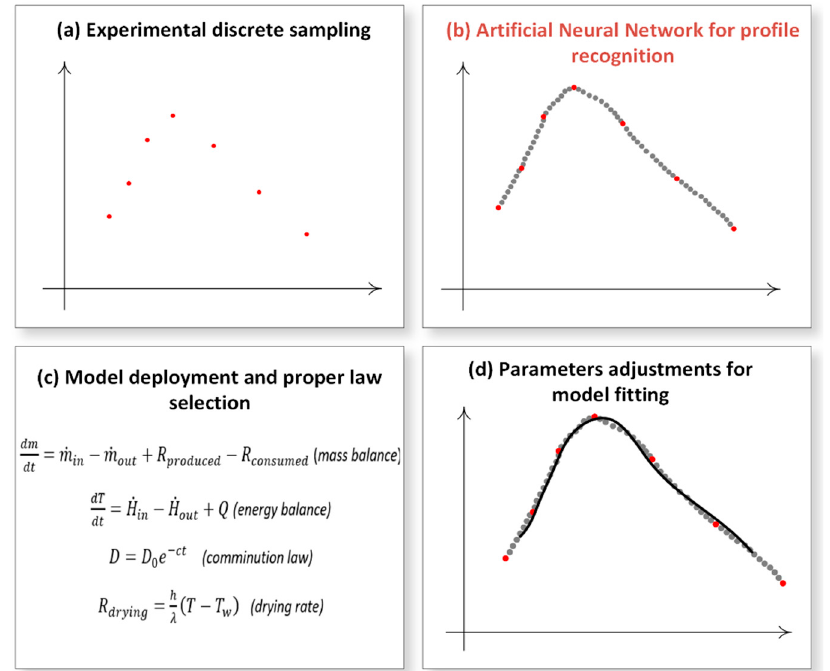
Figure 1. Digital twin deployment and parameter estimation strategy by steps: ( a ) real data sampling from the physical object, ( b ) data multiplication via pattern recognition using artificial intelligence algorithms aiming accuracy enhancement, ( c ) determination of the proper descriptive physical and empirical laws, and ( d ) adjustment of tuning parameters to achieve best curve fit.